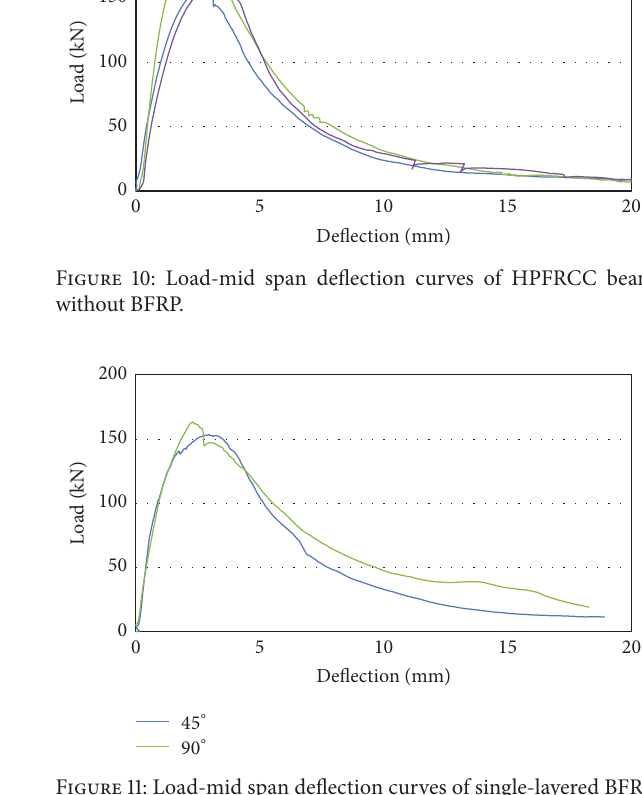
Figure 11: Load-mid span deflection curves of single-layered BFRP HPFRCC